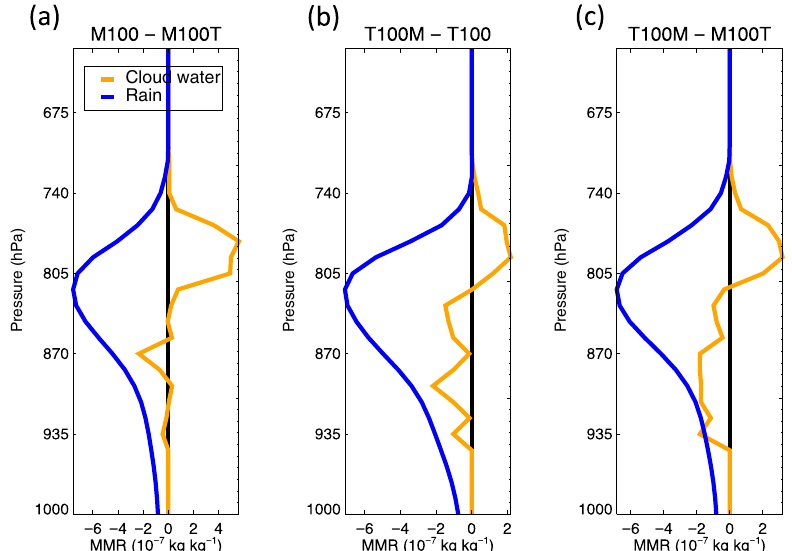
Figure 15. RICO case: difference in the cloudy column domain-mean vertical profiles of hydrometeor mass mixing ratios (MMR) between MORR and THOM, as in Fig. 11c, averaged over the 24h of the RICO simulation for the configurations with the autoconversion treatment swapped between the microphysics schemes (a) M100 minus M100T, (b) T100M minus T100 and (c) T100M minus